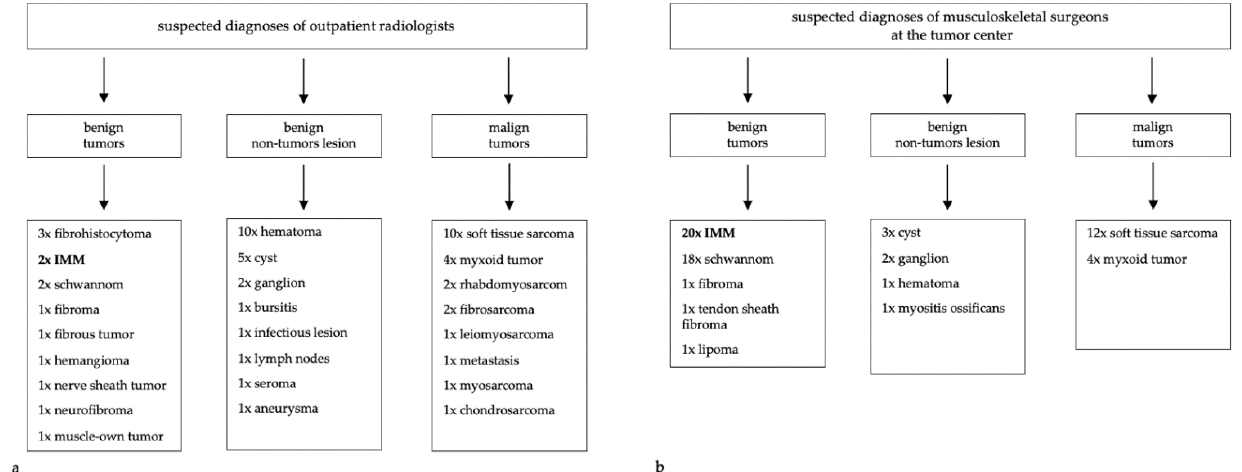
Figure 2. Suspected diagnoses by radiologists and musculoskeletal surgeons (multiple diagnosis per patient possible): ( a ) reported suspected diagnoses by the outpatient radiologists; ( b ) reported suspected diagnoses by the musculoskeletal surgeons at the specialized tumor center.